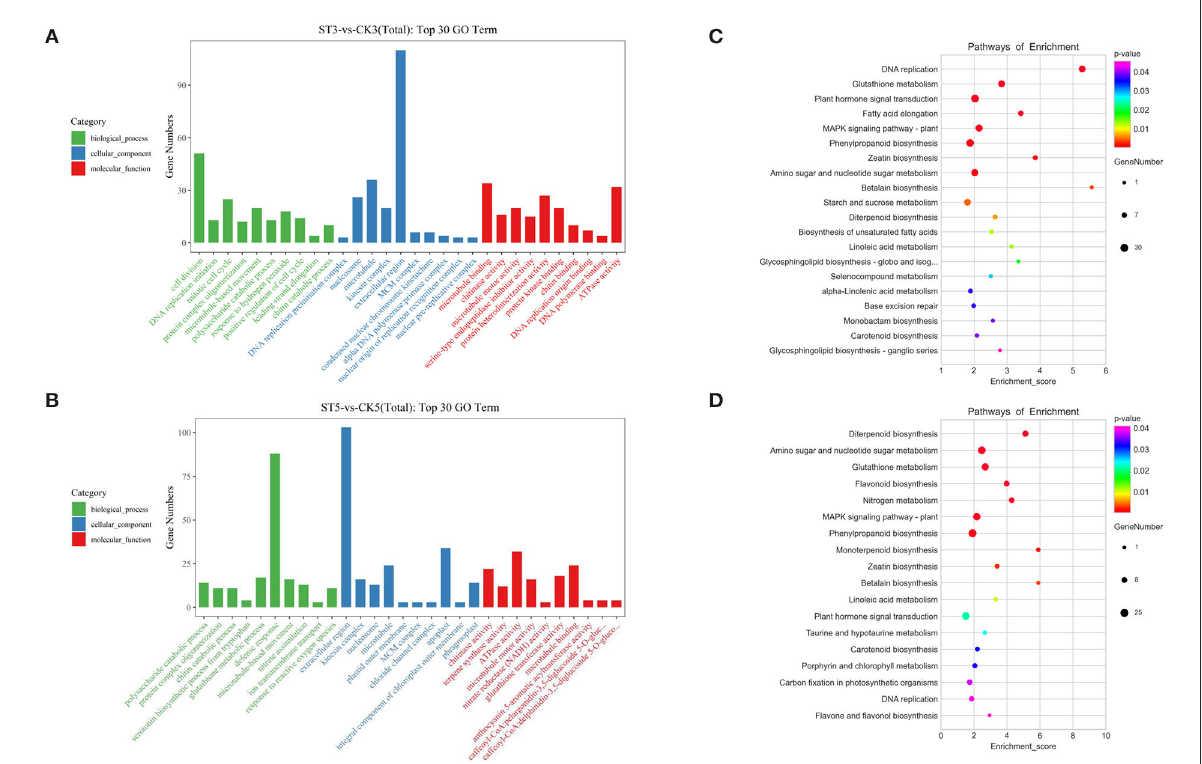
FIGURE3 Gene Ontology (GO) and Kyoto Encyclopedia of Genes and Genomes (KEGG) analyses of differentially expressed genes in response to salt stress. GO analysis at (A) 3 and (B) 5 d after salt treatment. KEGG analysis at (C) 3 and (D) 5 days after salt